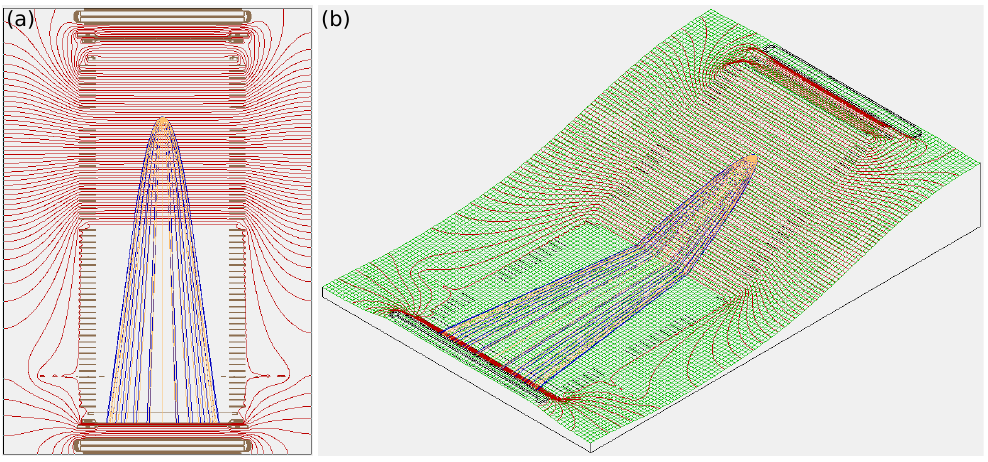
Figure 7. Ion trajectory simulation for CEI-type experiments. The electric filed strength is 460 V/cm. The trajectories of C 2 + with kinetic energy of 150 eV and C 3 + with kinetic energy of 250 eV are shown in orange and blue, respectively. The ejection angles relative to the spectrometer axis range from 0 to 360 degrees. ( a ) Side display of spectrometer equipotential lines (red) and particle trajecto- ries. ( b ) Spectrometer equipotential lines (red) and particle trajectories along the potential energy surface (green).